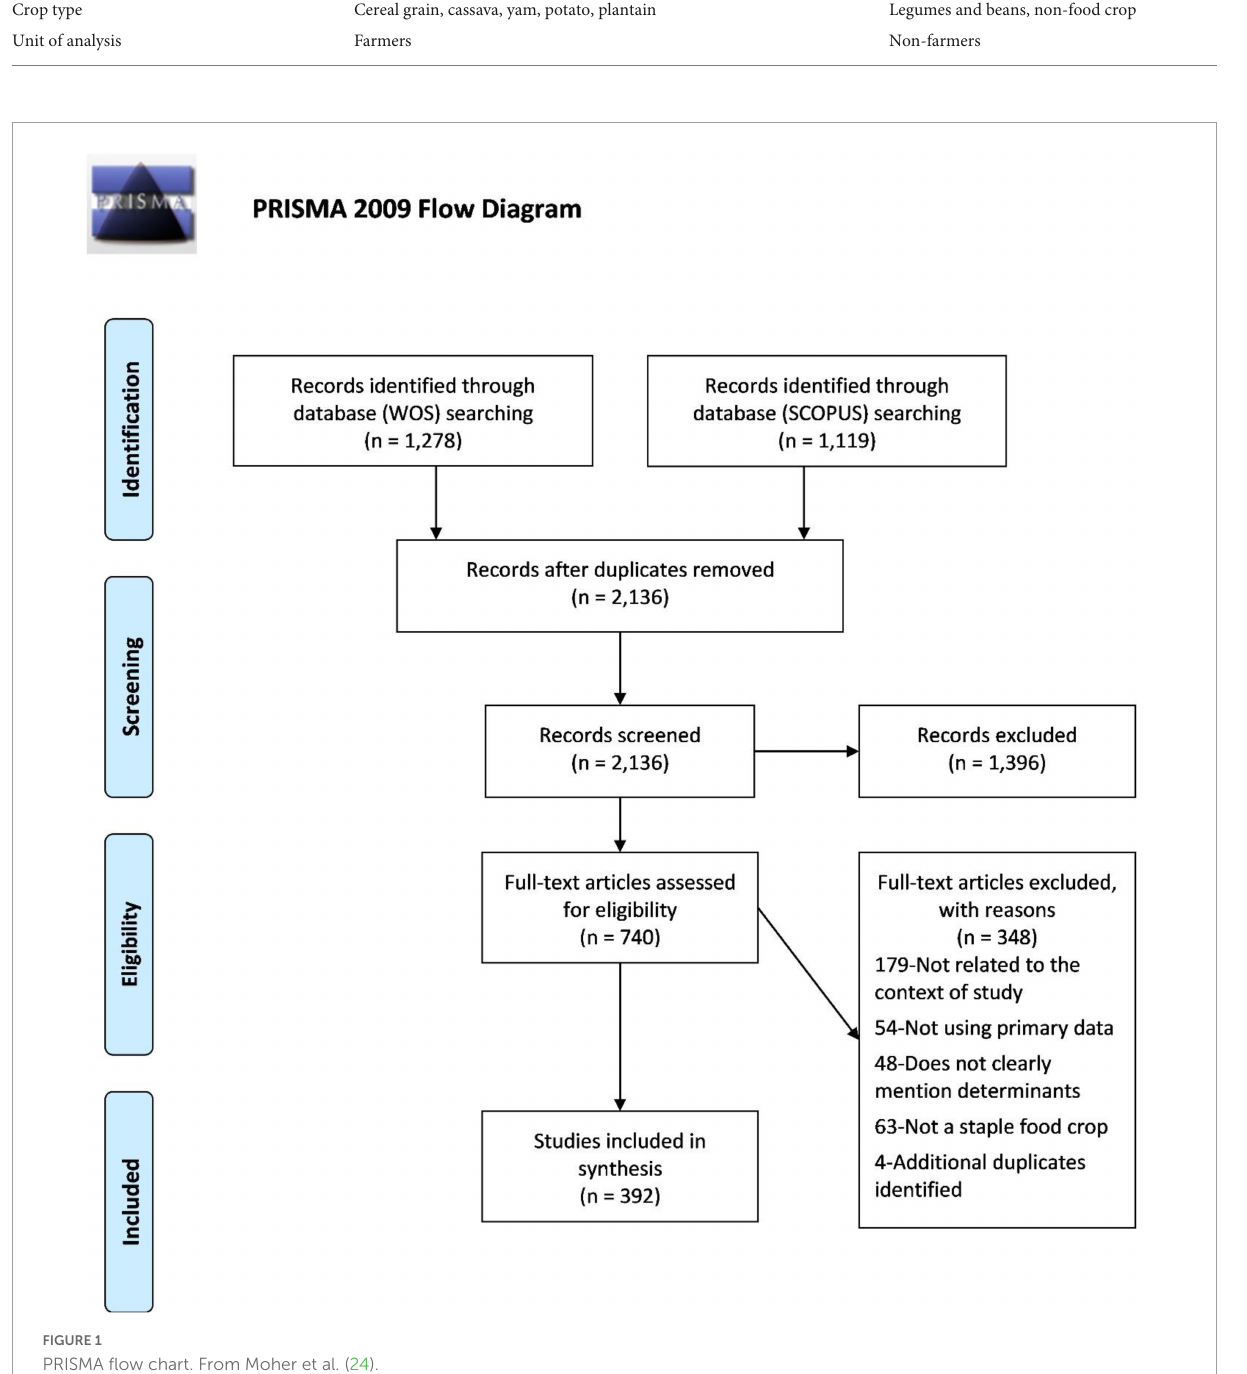
FIGURE1 PRISMA flow chart. From Moher et al.